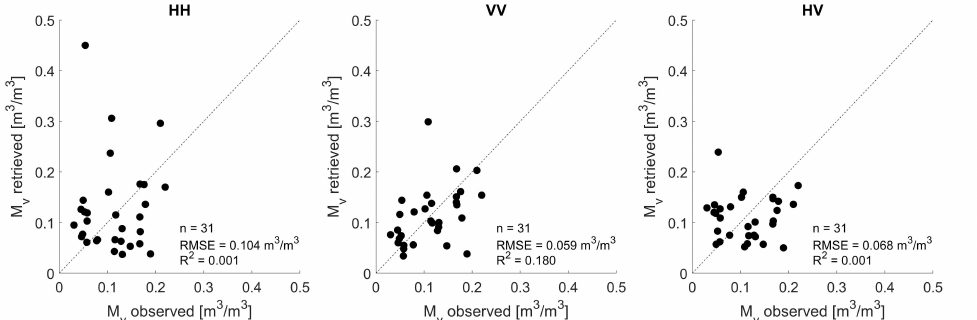
Figure 5. Retrieved field-average soil moisture values using in situ measured root-mean-square heights in the retrieval process with the Oh model against observed field-average soil moisture values, using single-polarized backscatter